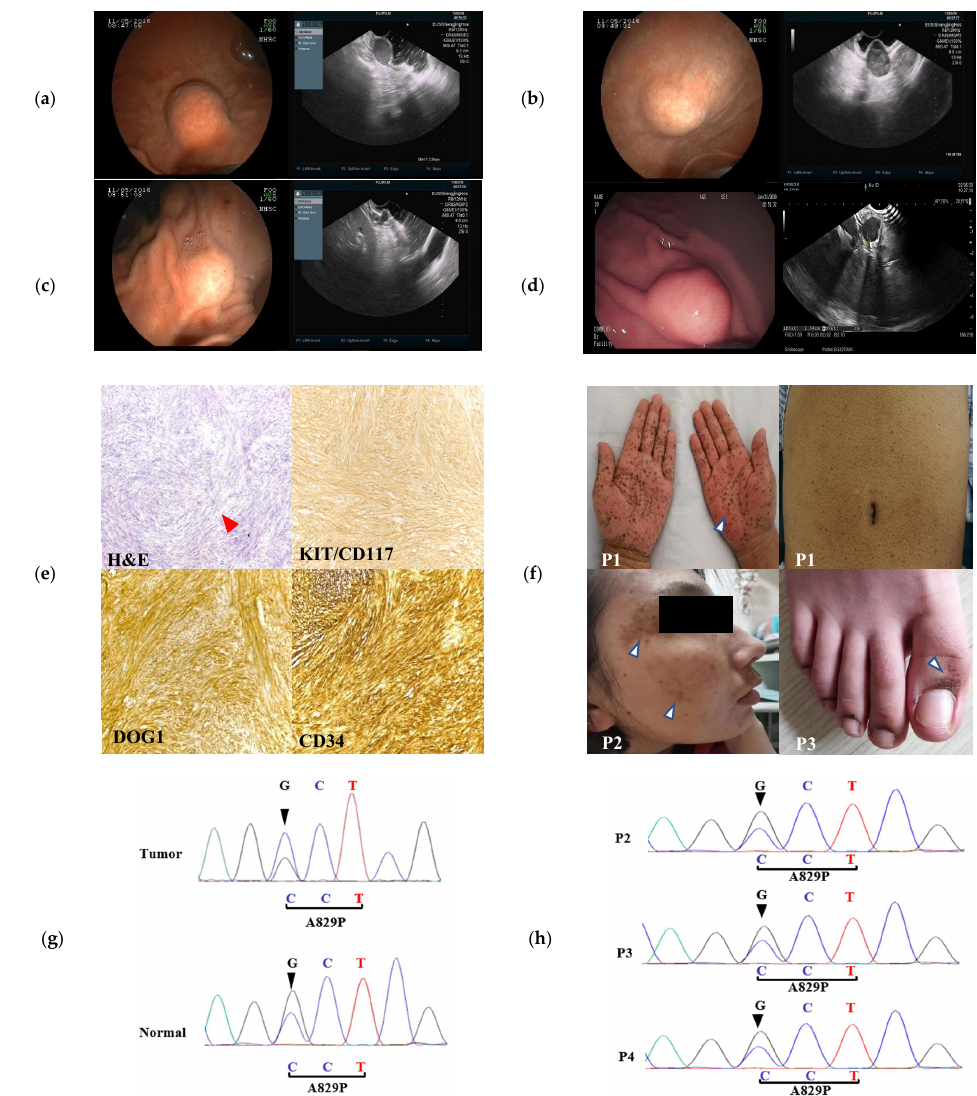
Figure 1. Clinicopathological presentations and molecular analysis of familial GISTs with hyperpig- mentation. ( a ) Endoscopic and endoscopic ultrasound (EUS) images of the proband showing the lesion at the gastric greater curvature (23 × 20 mm) originating from the muscularis propria. ( b ) Endoscopic and EUS images showing a lesion located at the lesser curvature (30 × 20 mm) originat- ing from the muscularis propria with echogenic heterogeneity, regular margins, and exophytic growth. ( c ) Endoscopic and EUS images of the proband showing a lesion at the lesser curves (10 × 8 mm) originating from the muscularis propria with echogenic heterogeneity and regular margins. ( d ) Endoscopic and EUS images of patient 2 (P2; niece of the proband) showing a lesion in the fun- dus (12 × 9 mm) originating from the muscularis propria with homogeneous echogenicity and reg- ular margins. ( e ) Hematoxylin and eosin staining of the proband’s largest lesion, revealing bundles of spindle cells arranged in fascicles (red arrow). Tumor cells display positive immunoreactivity for KIT/CD117, DOG1, and CD34 (original magnification, ×20). ( f ) Cutaneous hyperpigmentation of three family members (P1, P2, and P3). ( g ) Sanger sequencing of the proband’s tumor DNA, reveal- ing a G-to-C transversion at codon 829 of KIT exon 18, which resulted in an A829P amino acid change. The same KIT mutation was identified in oral epithelial cell DNA (normal), indicating a germline origin. ( h ) Targeted Sanger sequencing of three other family members with hyperpigmen- tation revealed the same mutation.